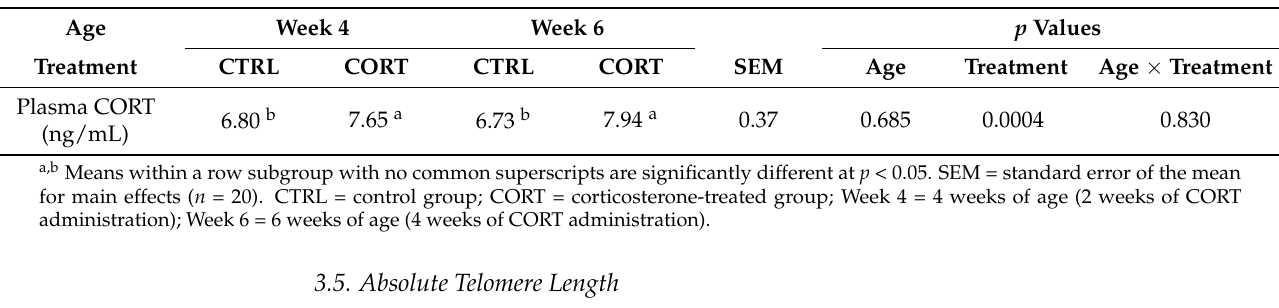
Table 6. Effect of corticosterone administration on plasma corticosterone